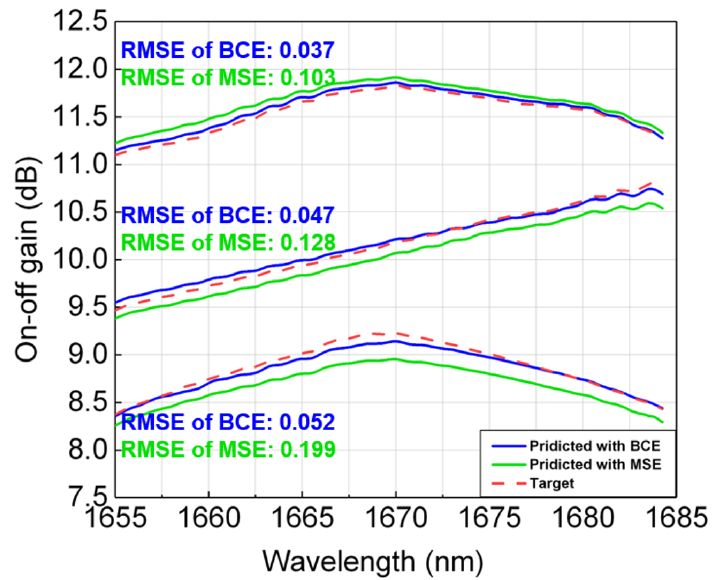
Figure 3. The performance of MSE loss function and BCE loss function.